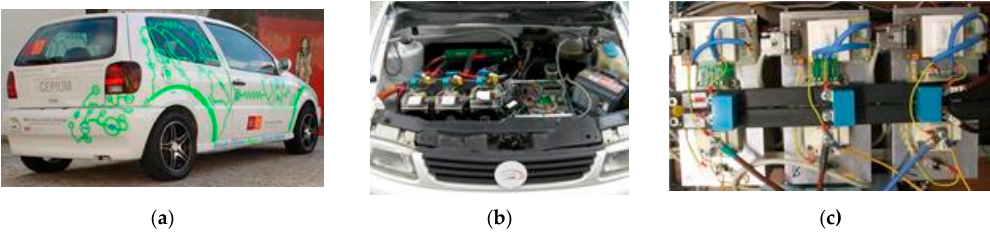
Figure 23. Developed prototype of a plug-in EV (CEPIUM— Carro Elétrico Plug-In da Universidade do Minho ): ( a ) EV prototype; ( b ) powertrain; ( c ) power converter detail.